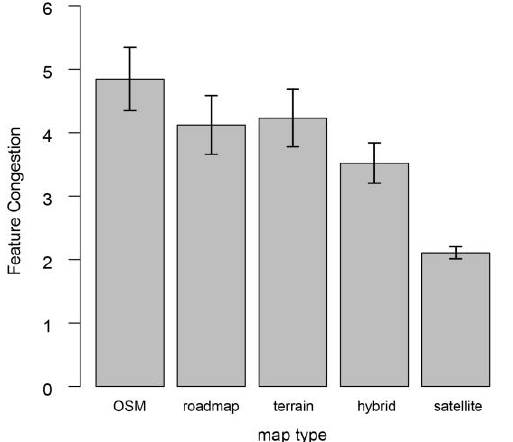
Figure 3. Mean Feature Congestion of examined types of geovisualizations. Error bars correspond to M ± 2×SE.